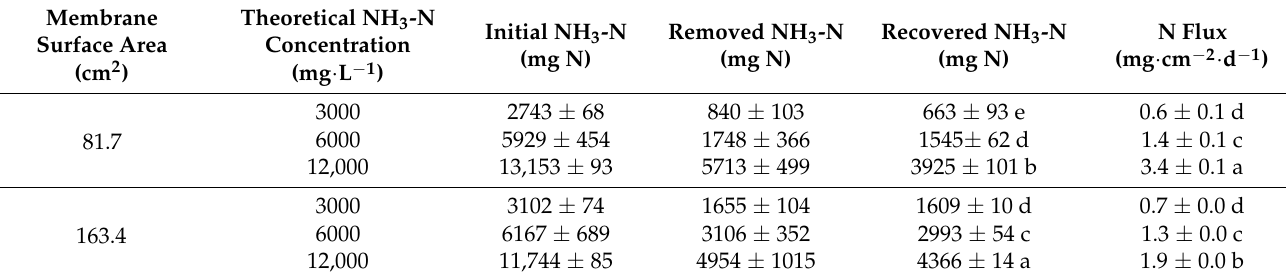
Table 1. Initial NH 3 mass in the synthetic solution (Initial N-NH 3 ), NH 3 mass removed from the liquid (Removed N-NH 3 ), NH 3 mass recovered in the acidic solution (Recovered N-NH 3 ), and N flux as a function of the NH 3 -N concentration in the N emitting solution for two membrane surface areas (81.7 and 163.4 cm 2